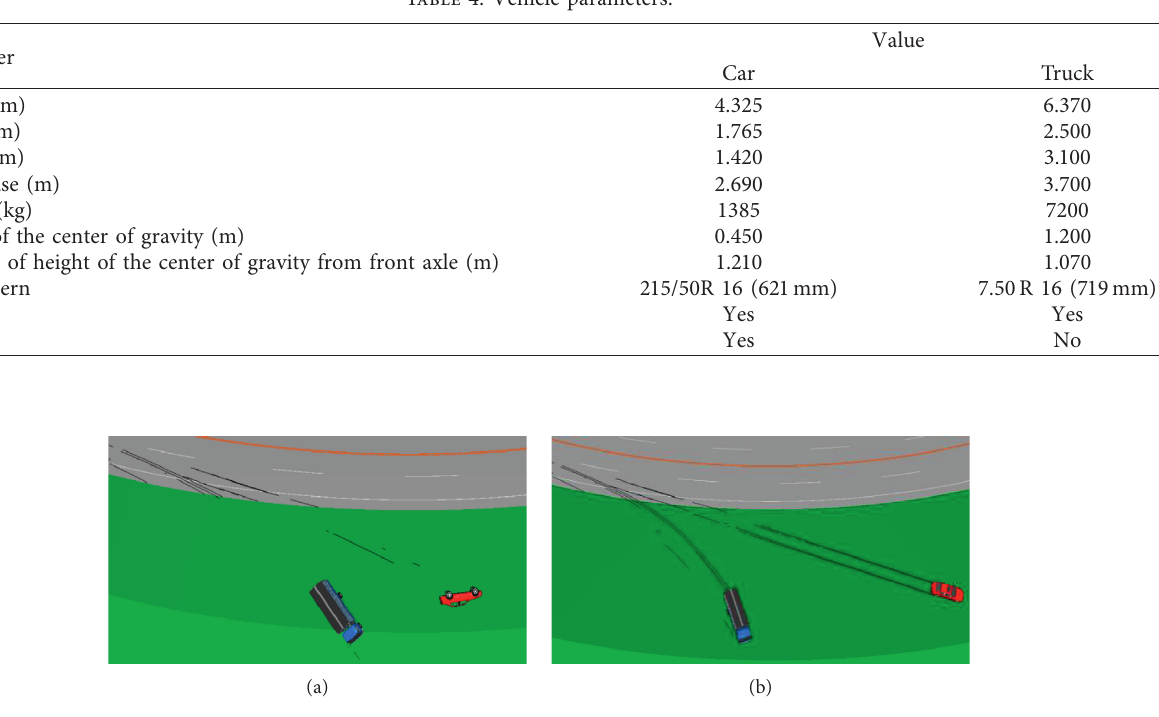
Figure 4: Vehicle motion states: (a) rollover and (b)